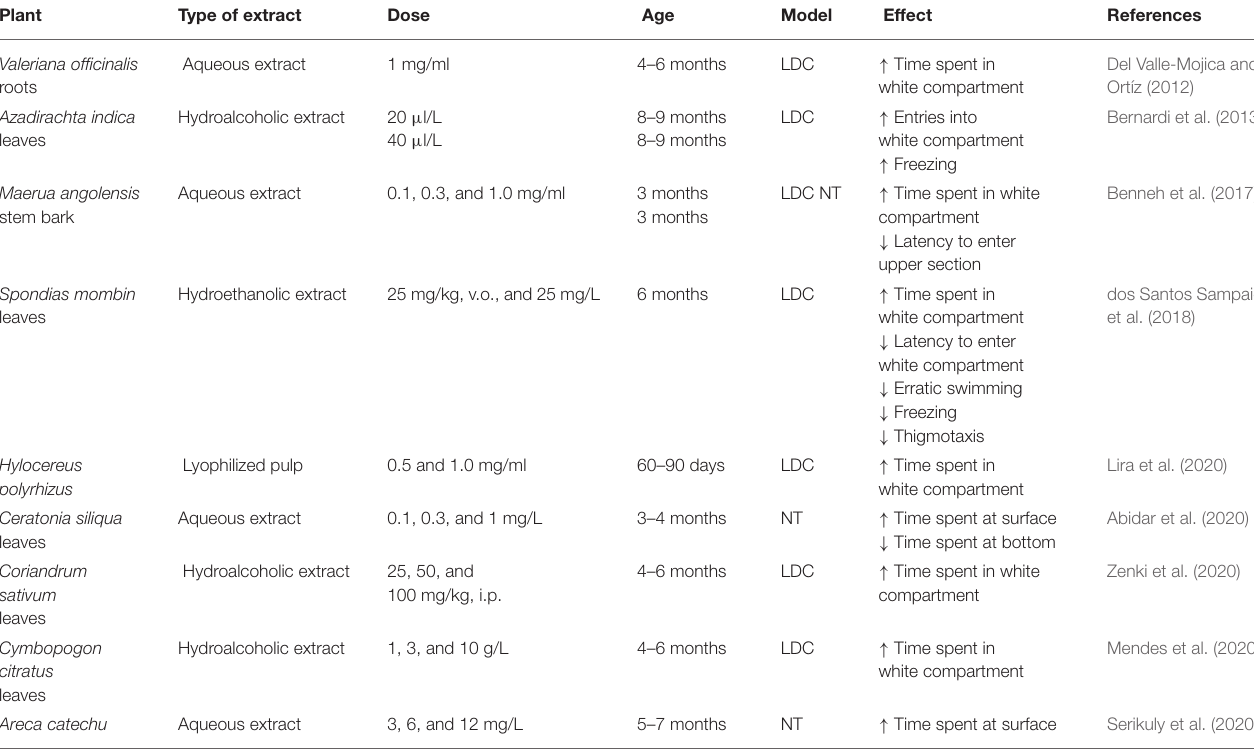
TABLE 1 | Behavioral effects of plant extracts in adult zebrafish.